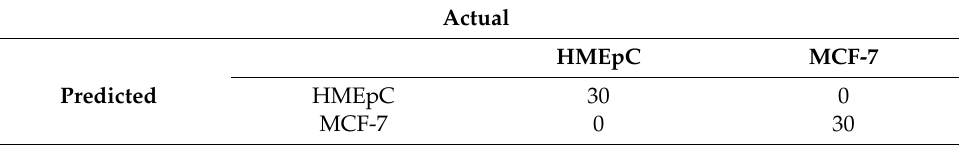
Table 2. Confusion matrix of SVM.